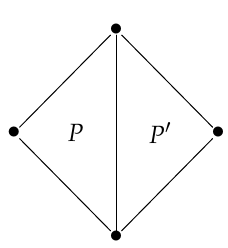
Figure 3. A topologically consistent configuration of two distinct triangles G ( left ) and G (cid:48) ( right